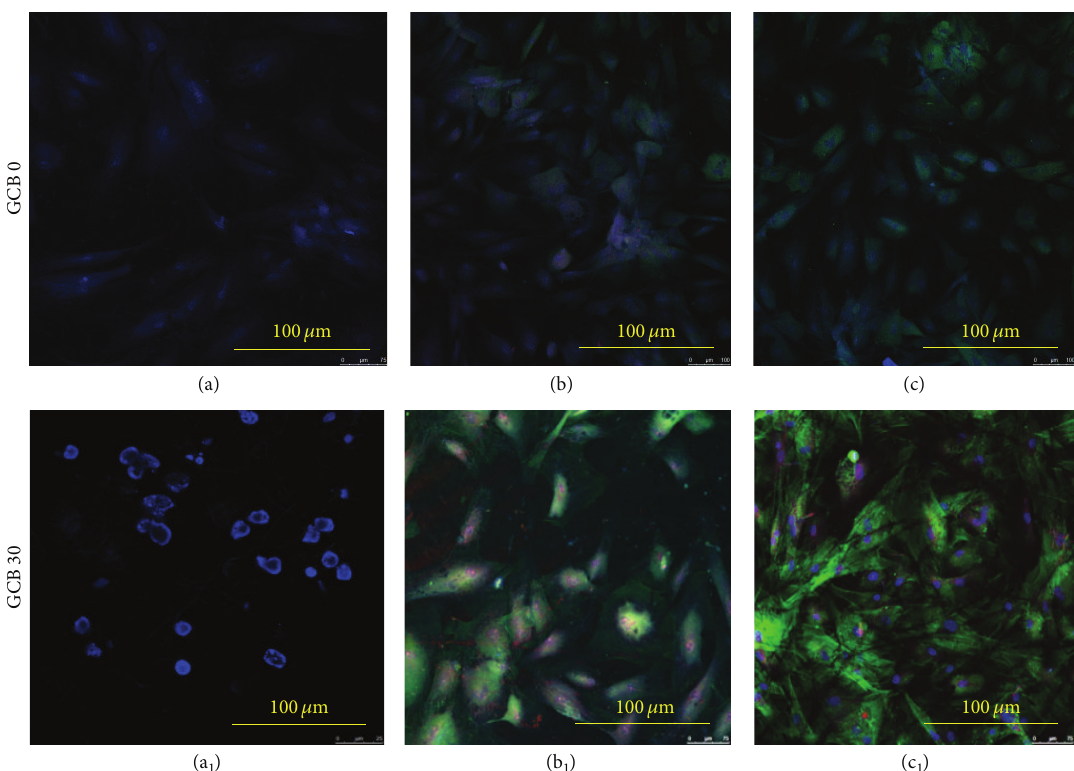
Figure 14: Fluorescence image of MSC’s cells cultured on GCB 30 scaffolds prepared from solutions with bioglass concentration of 30% on (a) 1 day, (b) 7 days, and (c) 14 days. In fluorescence images, osteocalcin is stained green, RUNX2 is stained red, and nuclei are stained